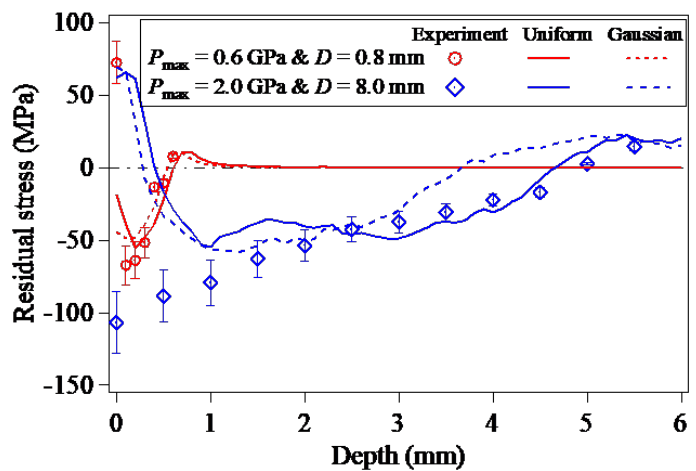
Figure 3. In − depth residual stresses induced by LSP[34]. Figure 3. In-depth residual stresses induced by LSP [34]. The LSP-induced residual stresses are the results of the recovery of the elastic defor- mations surrounding the plastically-deformed zone, and are essentially dependent on the plastic deformations caused by LSP. Figure 4 shows the in-depth equivalent plastic strains along the Path-Z, which can be used for describing the plastic deformations quantitatively. Under the same LSP conditions (the peak pressure of laser plasma-induced shock wave and laser spot size), with regard to the same depth, the equivalent plastic strain induced by LSP associated with the loading of the uniformly-distributed laser plasma-induced shock wave pressure is larger than that associated with the loading of the Gaussian distribution of laser plasma-induced shock wave pressure, which is consistent with the depth of the LSP-induced compressive residual stress field.